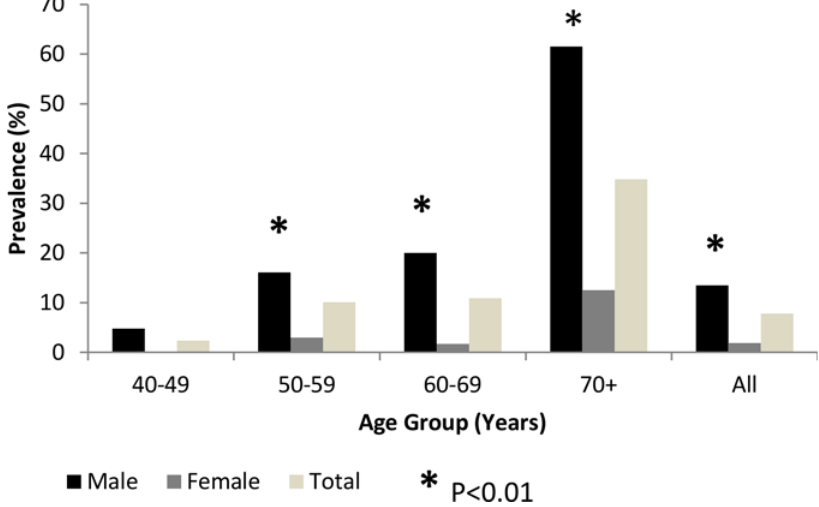
Fig 2. Prevalence of COPD (GOLD I and higher COPD) by gender and age groups. Chronic Obstructive Pulmonary Disease; GOLD I: Global Initiative for Chronic Obstructive Lung Disease Stage I COPD; * : p < 0.01, Significant difference between male and female according to